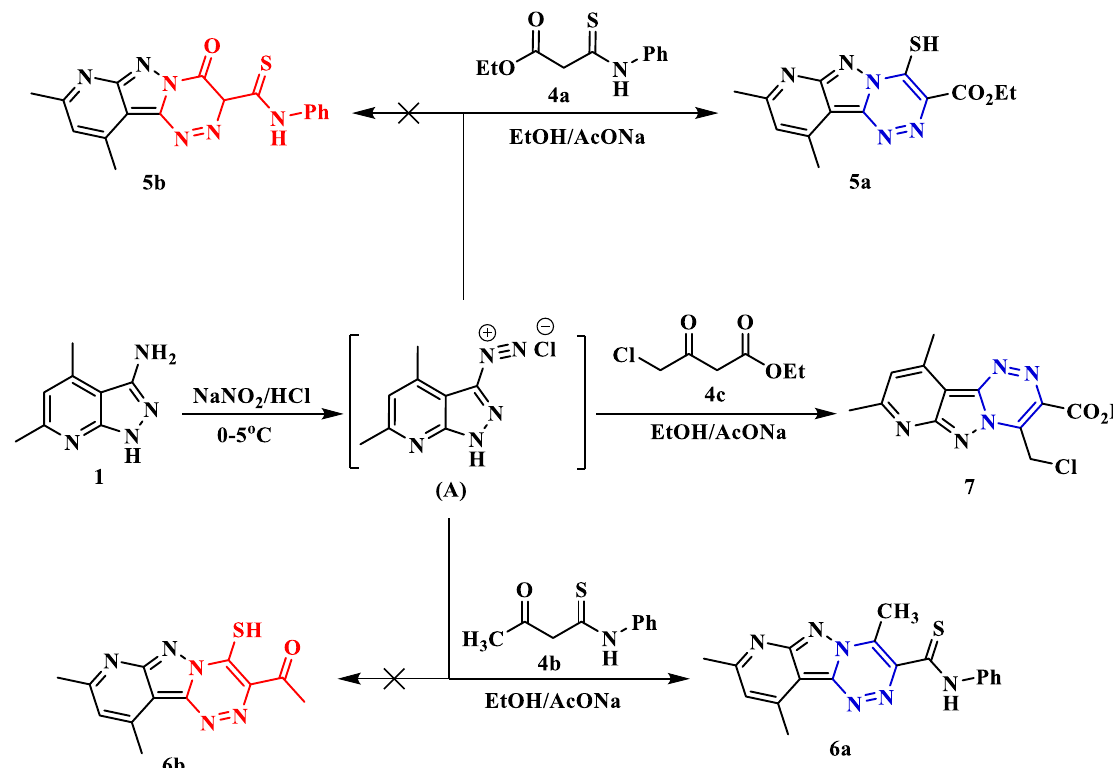
Figure 3. Synthesis of pyridopyrazolo-triazine derivatives 5a , 6a , and 7